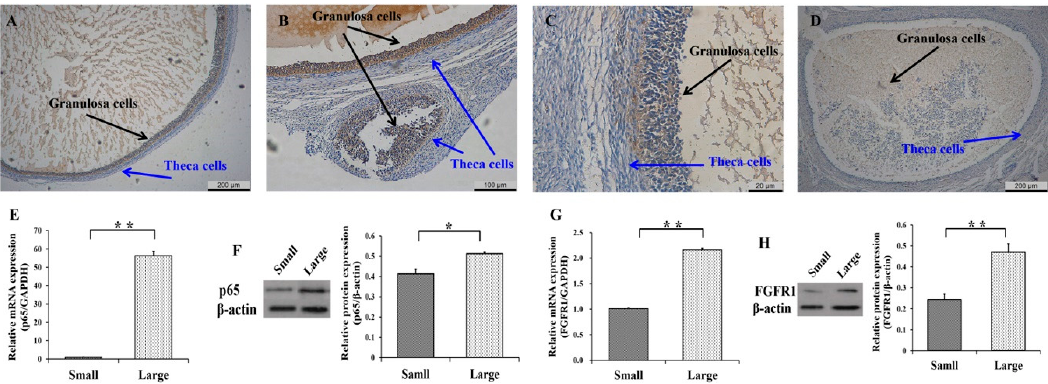
Figure 1. Expression patterns of p65 and FGFR1 in follicles and granulosa cells (GCs). The representations of immunohistochemical results of p65 ( A and B ) and FGFR1 ( C and D ) in large and small follicles, respectively. The relative mRNA ( E ) and protein ( F ) levels of p65 in small and large follicles. The relative mRNA ( G ) and protein ( H ) levels of FGFR1 in small and large follicles. * indicates p < 0.05; ** indicates p < 0.01. Scale bars: 200 μ m for 5× figures; 100 μ m for 10× figures; 20 μ m for 20× figures.